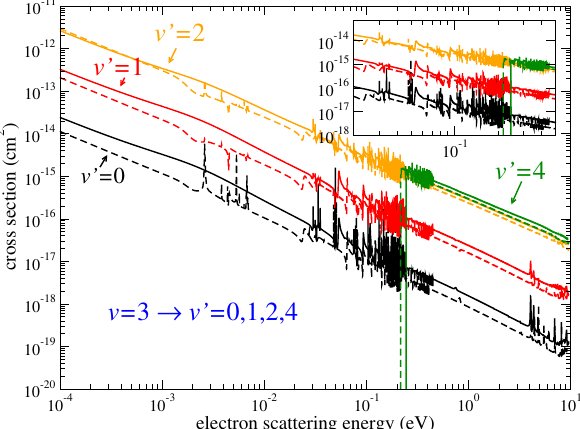
Figure 1. Cross sections of vibrational (de-)excitation from the vibrational level v = 3 to several other levels v (cid:48) of 4 HeH + (solid lines) and 4 HeD + (dashed